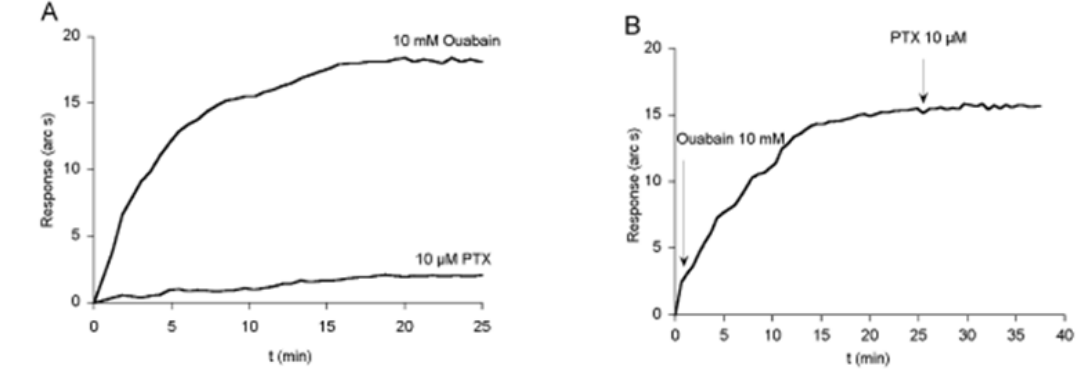
Figure 12 . Porcine cerebral cortex Na + ,K + -ATPase -ouabain/PTX association. (A) Association curves of 10mM ouabain or 10 μ M palytoxin added over immobilized Na + ,K + - ATPase. (B) Association curve after addition of 10mM ouabain (first arrow) over immobilized Na + ,K + -ATPase. PTX of 10 mM was added 25 min later (second arrow). Reproduced from